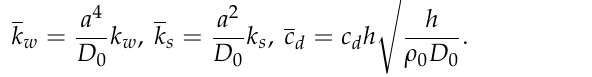
(cid:112) ρ h / D 0 for isotropic square